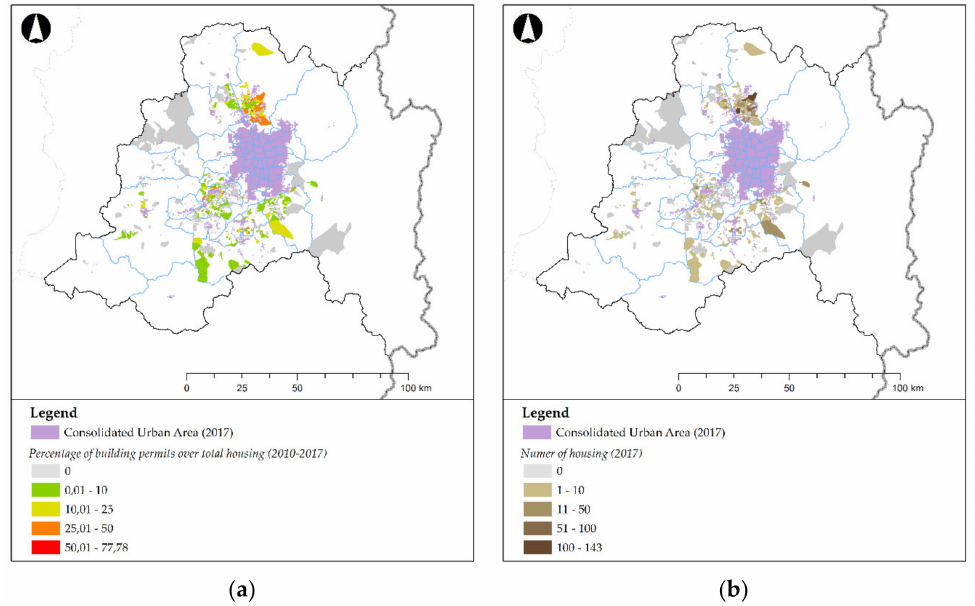
Figure 8. ( a ) Percentage of building permits (2010–2017) over total housing and ( b ) total number of housing units (2017). Source: Own elaboration, based on INE (2017) and MINVU